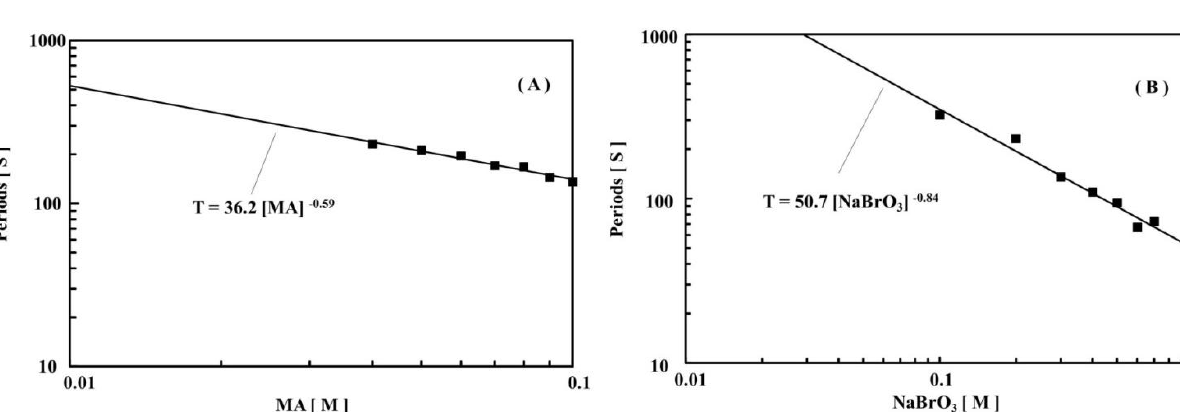
Figure 6. Logarithmic plots of period T (in s) vs. initial molar concentration of one BZ substrate at a constant temperature ( T = 20 °C) under fixed concentrations of the other